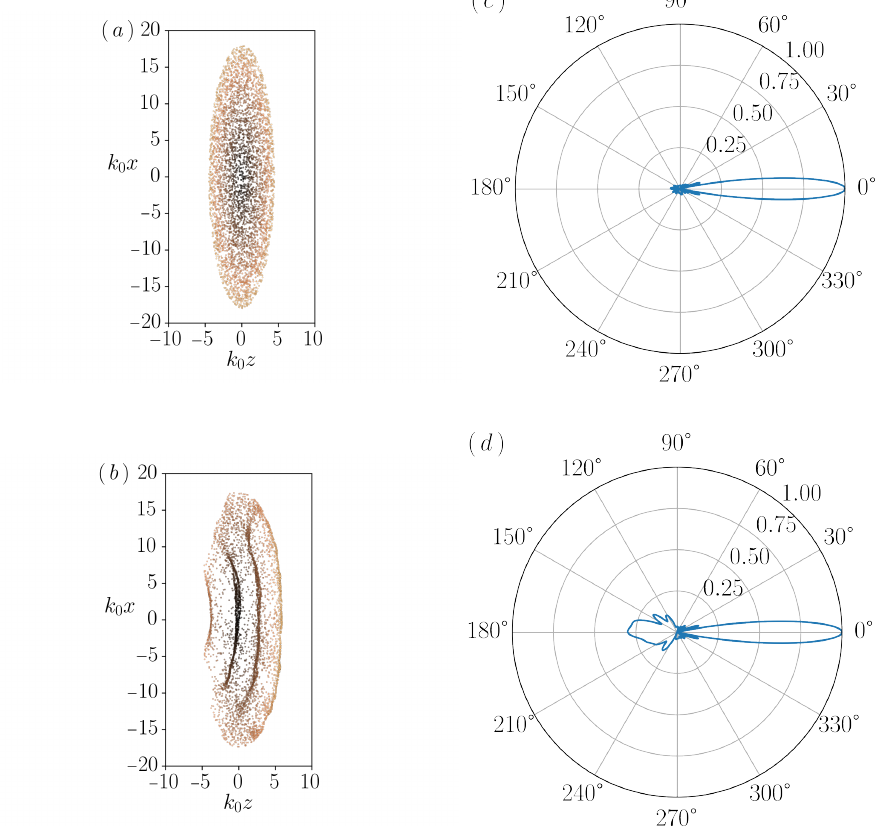
Figure 2. Collective scattering and pattern formation from an elliptical 2D atomic cloud irradiated with a pump field propagating perpendicular to its major axis and linearly polarized along the x axis: ( a ) Shows the initial random atomic density distribution of N = 5000. ( b ) Depicts the density grating formation due to collective scattering at t = 0.167 ω − 1 r . The corresponding bunching factors | M ( k , t ) | for both time instants are displayed in ( c ), for the initial state, and in ( d ), for t = 0.167 ω − 1 r